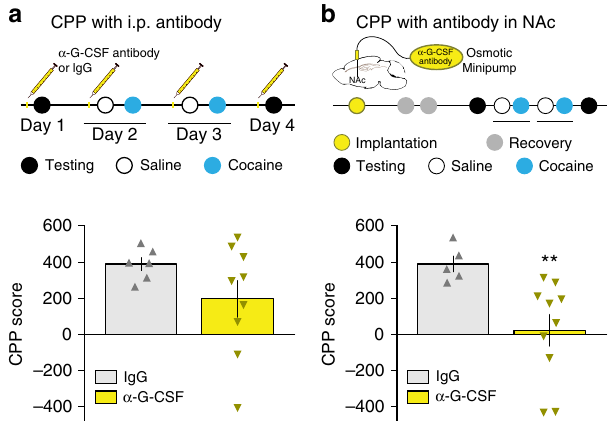
Fig. 7 Neutralization of central G-CSF signaling reduces conditioned place preference. a To determine the role of circulating G-CSF in behavior, mice (IgG: n = 6; α -G-CSF antibody: n = 9) were i.p. injected with anti-G-CSF antibody (10 µ g) or pre-immune IgG control antibody 1 h every day before testing for CPP at 7.5 mg kg − 1 of cocaine. Systemic anti-G-CSF antibody did not signi fi cantly affect cocaine CPP (Two-tailed Student ’ s t -test: t (13) = 1.48, p = 0.16). b To test the effects of blocking signaling in the NAc anti-G-CSF antibody or pre-immune IgG (1 µ g/side) was infused into the NAc via continuous osmotic minipump before and during testing for CPP at 7.5 mg kg − 1 of cocaine (IgG: n = 5; α -G-CSF antibody: n = 10). NAc infusion of anti- G-CSF antibody blocked cocaine CPP ( t (12.4) = 3.75, p = 0.0026). Data represented as mean ± s.e.m (** p < 0.01 for t